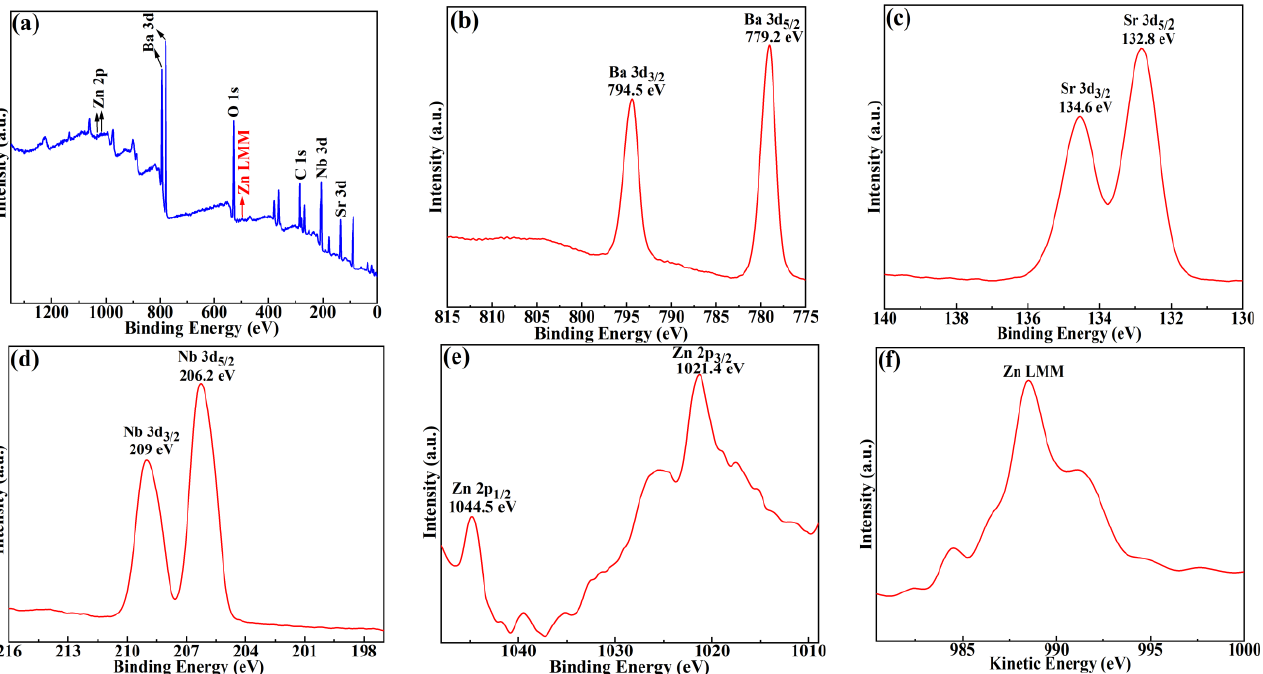
Figure 5. XPS spectra of Ba 1 − x Sr x (Zn 1/3 Nb 2/3 )O 3 ( x = 0.2) ceramics with ( a ) full spectra, ( b ) Ba 3d, ( c ) Sr 3d, ( d ) Nb 3d, ( e ) Zn 2p, and ( f ) Zn LMM.